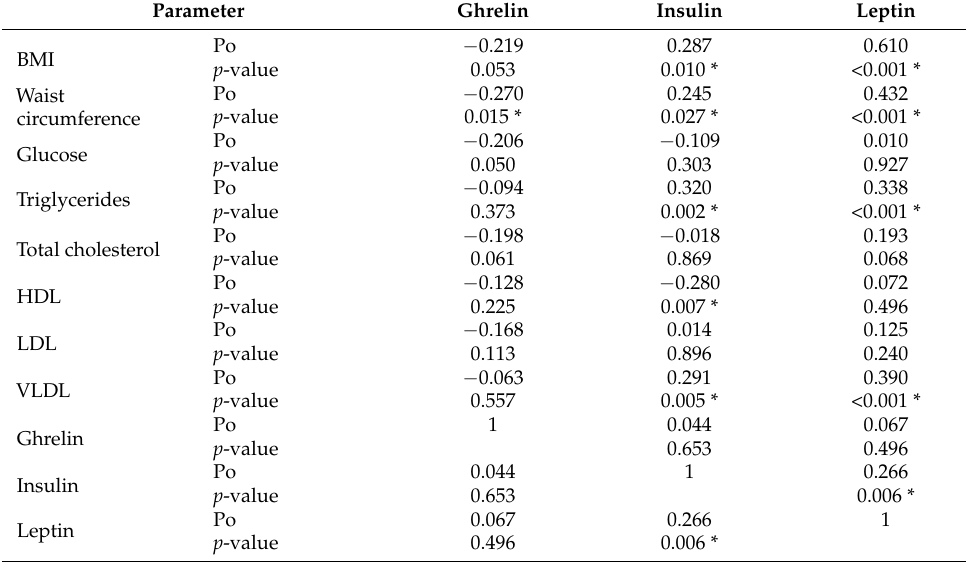
Table 4. Spearman’s correlation analysis between hormones, body mass index and biochemical parameters of the lipid spectrum in patients without metabolic syndrome.